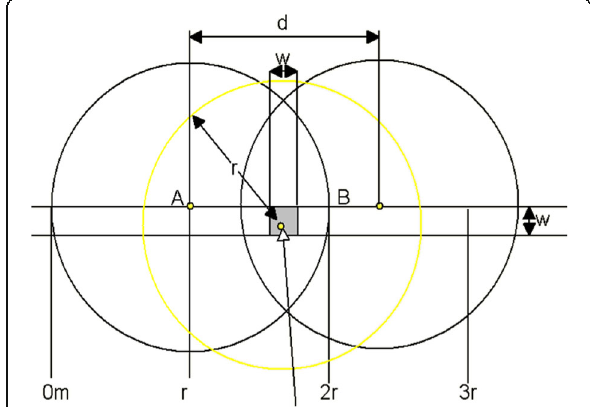
Fig. 1 Anchor box node distribution. The mine has a narrow roadway, roadway width w, A and B two anchor nodes, the node communication radius r, anchor nodes separated by cloth on the side of the roadway d, d less than 2r that any two anchors inter-node communication radius overlap; the anchor box width is limited to the roadway width, length is limited to the roadway width